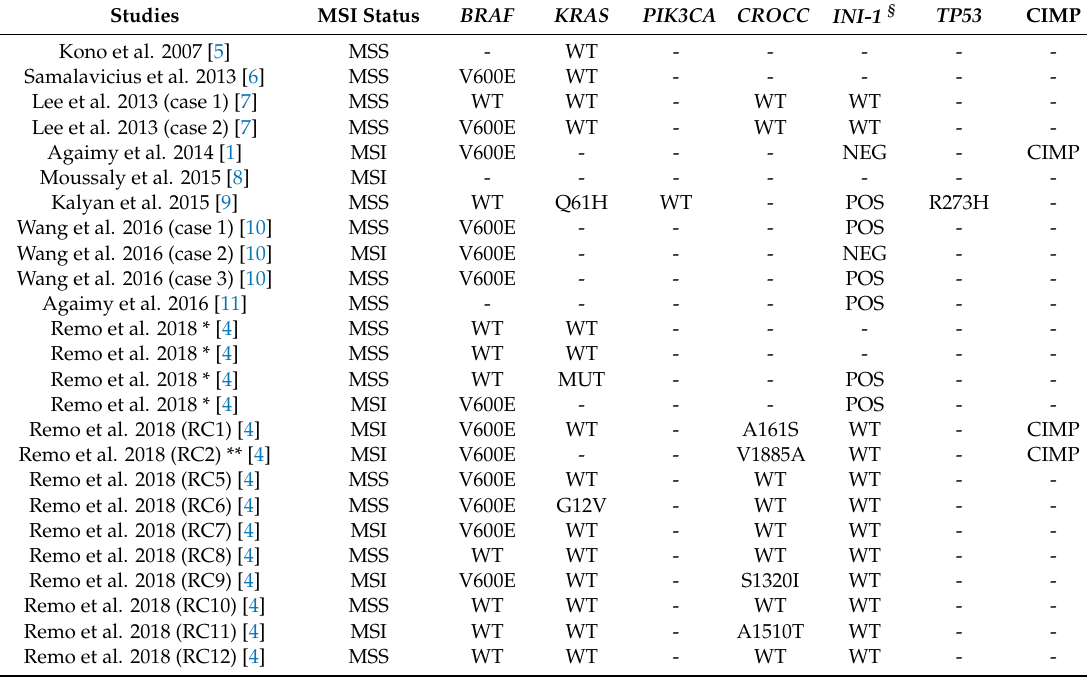
Table 1. Molecular data of colorectal rhabdoid carcinomas (CRbCs) previously